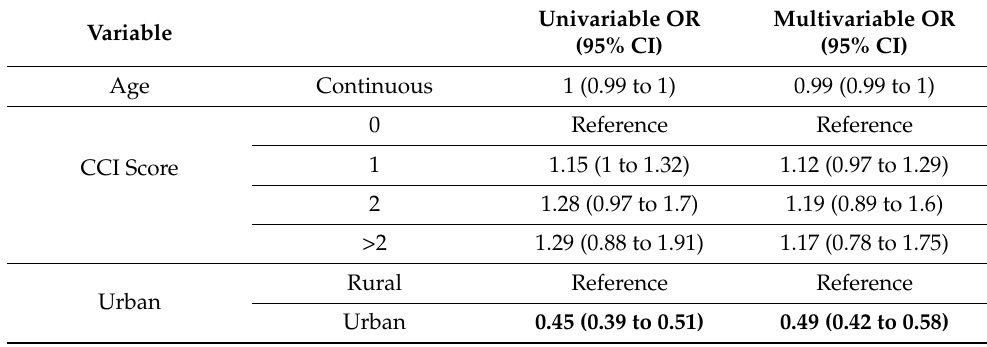
Table 2. Univariable and multivariable logistic regression models for ED only. Statistically significant values are bolded. OR: odds ratio; CI: confidence interval; CCI: Charlson Comorbidity index; G-CSF: granulocyte-colony stimulating